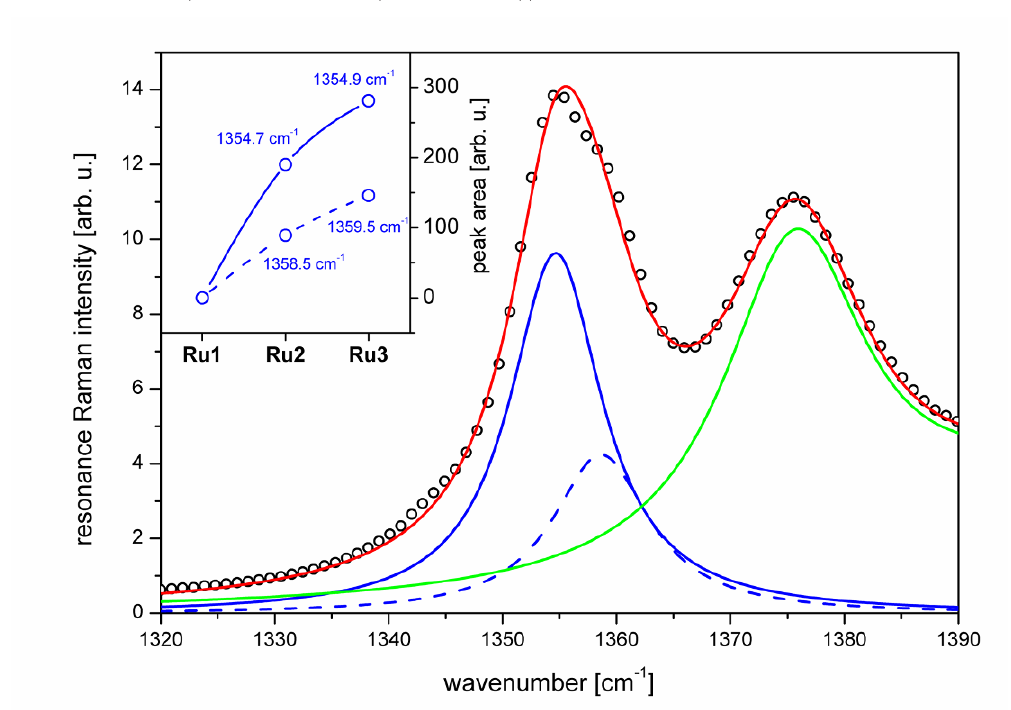
Fit of the resonance Raman spectra of Ru2 (circles) in the spectral region between 1320 and 1390 cm -1 by a sum of three Lorentz bands (red solid line). Two peaks correspond to molecular vibrations of Ru2 (blue solid and dashed line) while the solid green line represents solvent signals (acetonitrile). The inset shows the respective integrated peak areas for the series Ru1, Ru2 and